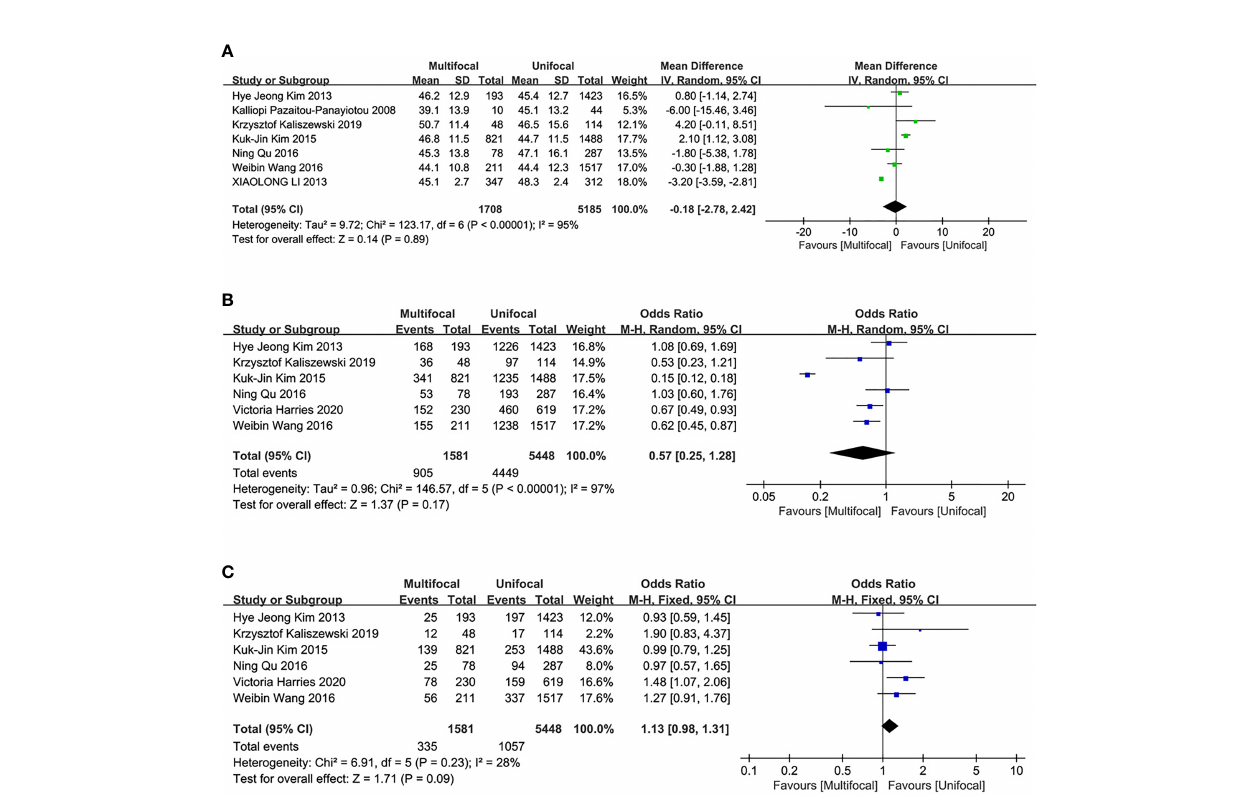
FIGURE 2 | Meta-analysis results for the difference between the UMPTC and UUPTC. (A) Age; (B) Female; (C)